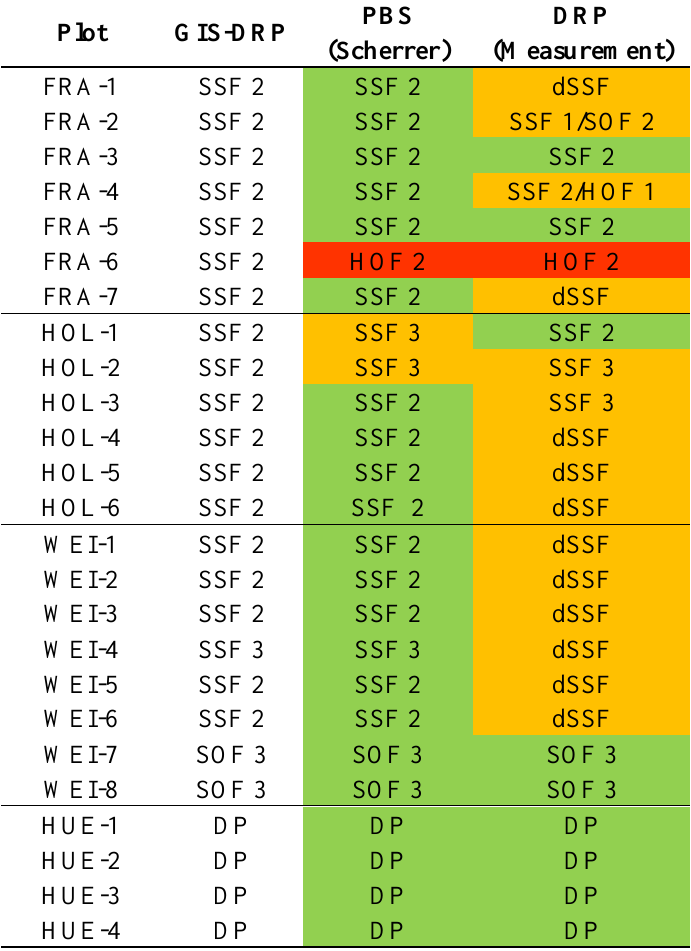
Table 3. Comparison of the results from the different DRP identification approaches.